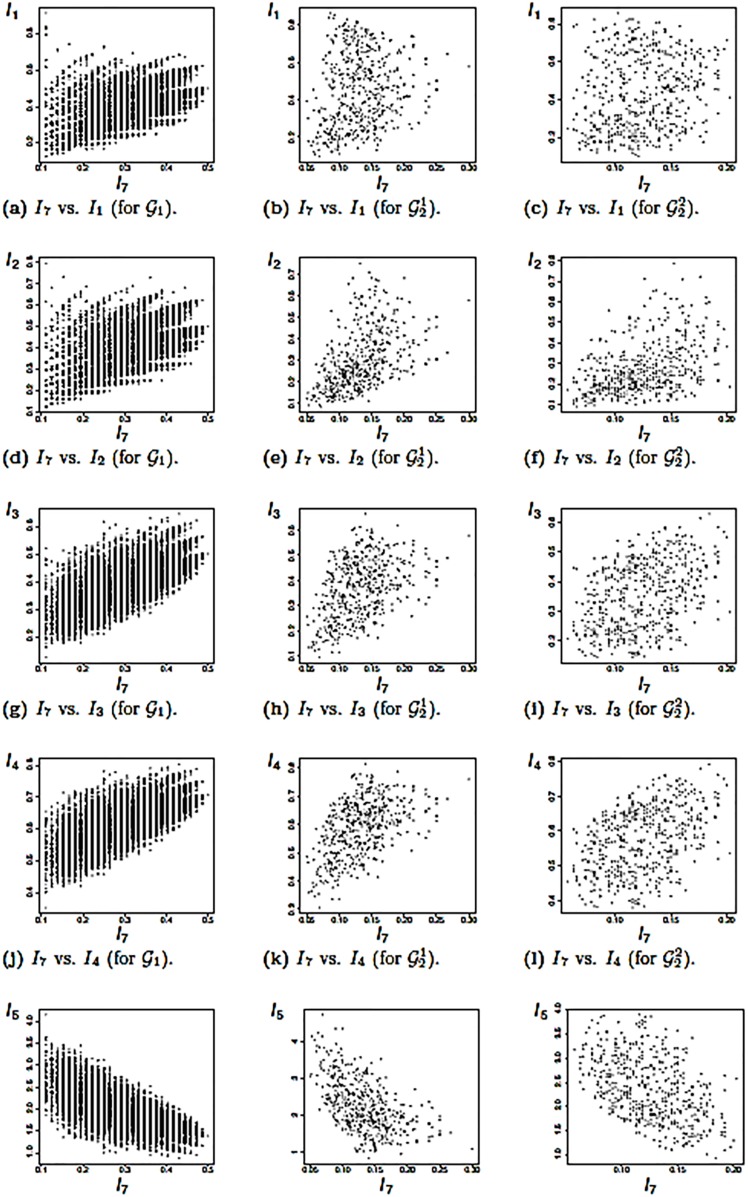
Scatter plots for I7 vs. Ij, 2 ≤ j ≤ 5.